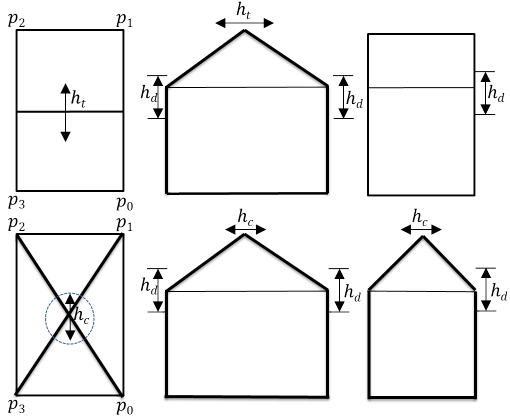
Figure 3: Top row: gable roof model including variance in build- ing heights ( h ) and ridge position ( h t ). Bottom row: Pinnacle d roof model showing hip intersection point tolerance circle with diameter h c .